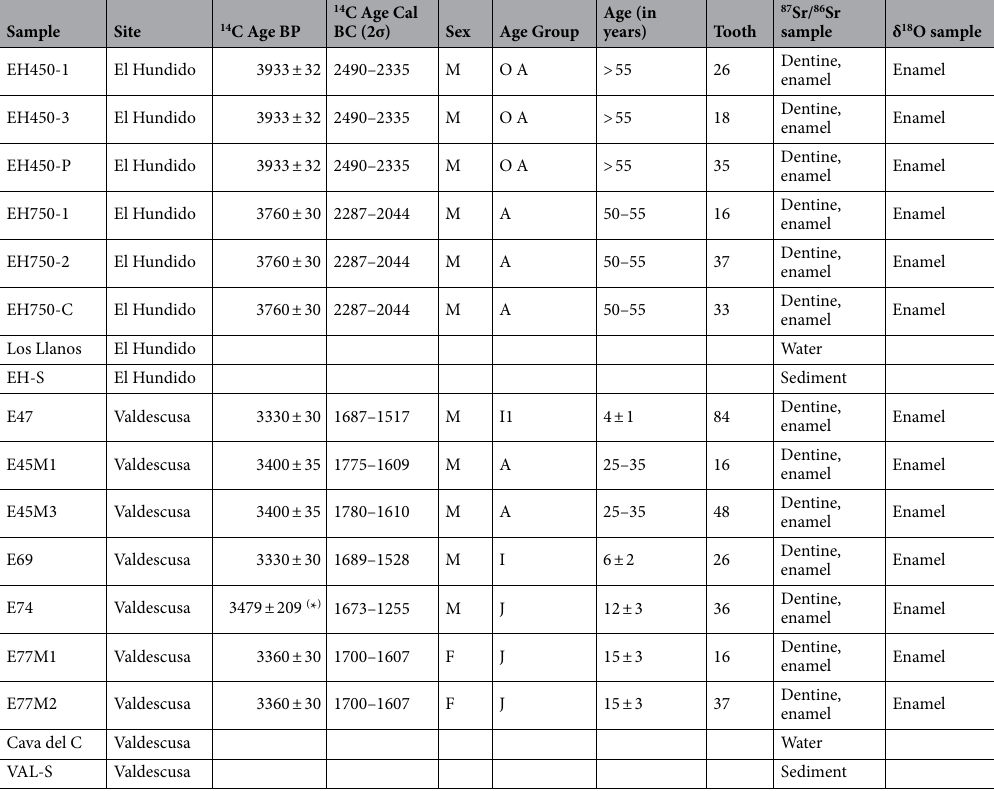
Table 1. List of samples for strontium and oxygen isotope analysis with main archaeological information. F: female, M: male, OA: old adult, A: adult, J: juvenile, I: infant. *Thermoluminescence dating. Bayesian adjustment of the absolute chronology of the funeral pit E-45 28